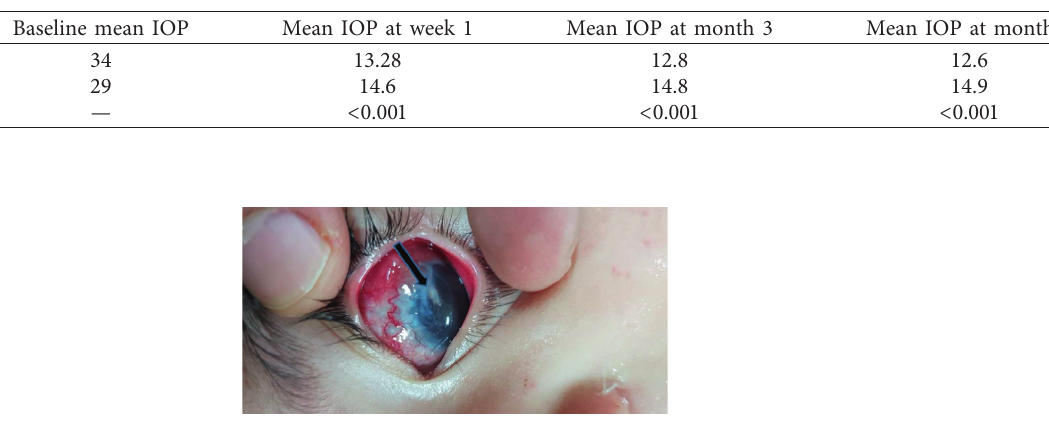
Table 2: Mean IOP at baseline and different study time points.